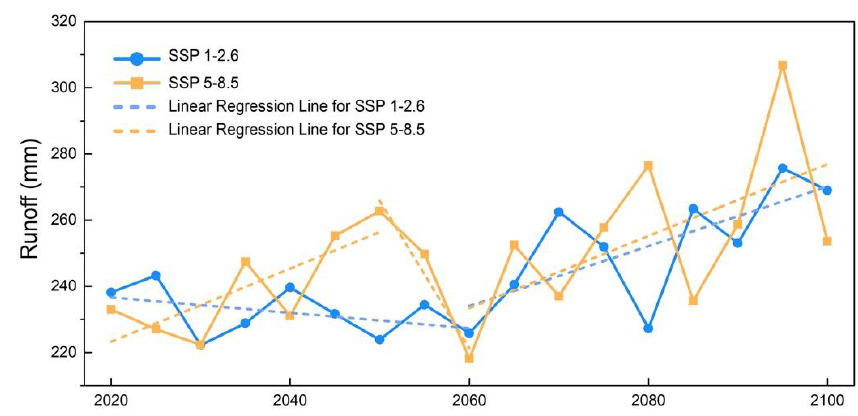
Figure 6. Annual total runoff under SSP 5-8.5 and SSP 1-2.6.